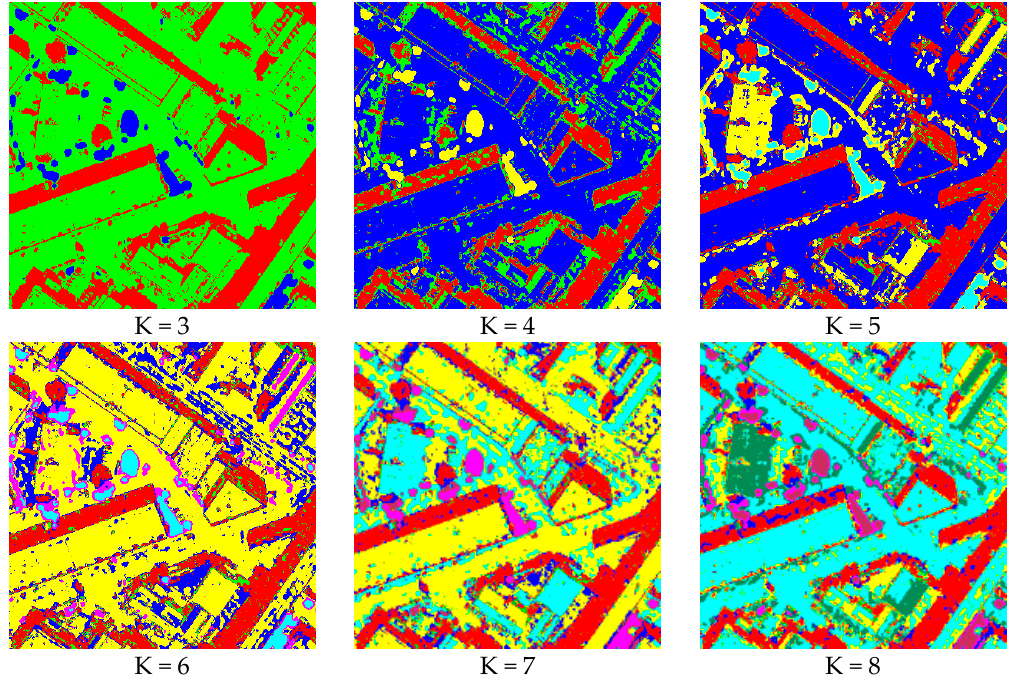
Figure 6. K-Means clustering results in the NCIFs feature space. Shadow cluster is shown by red.